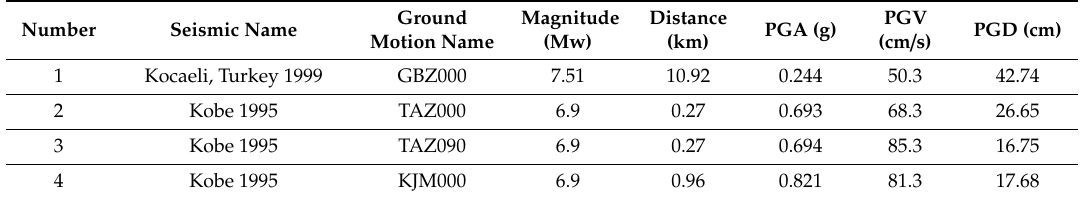
Table 1. Information of selected near-fault ground